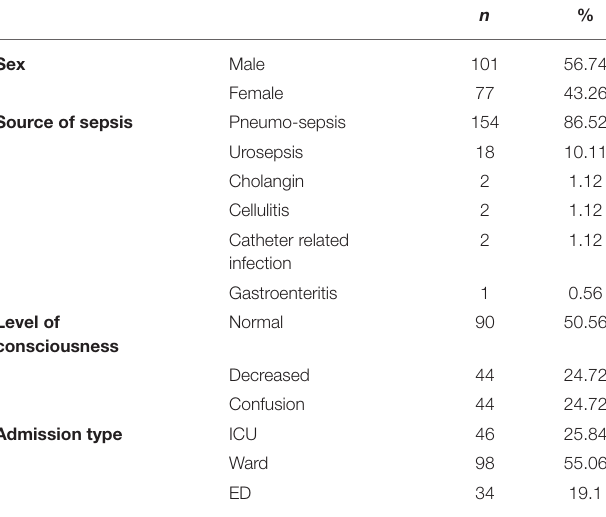
TABLE 1 | Demographic data and clinical parameters.